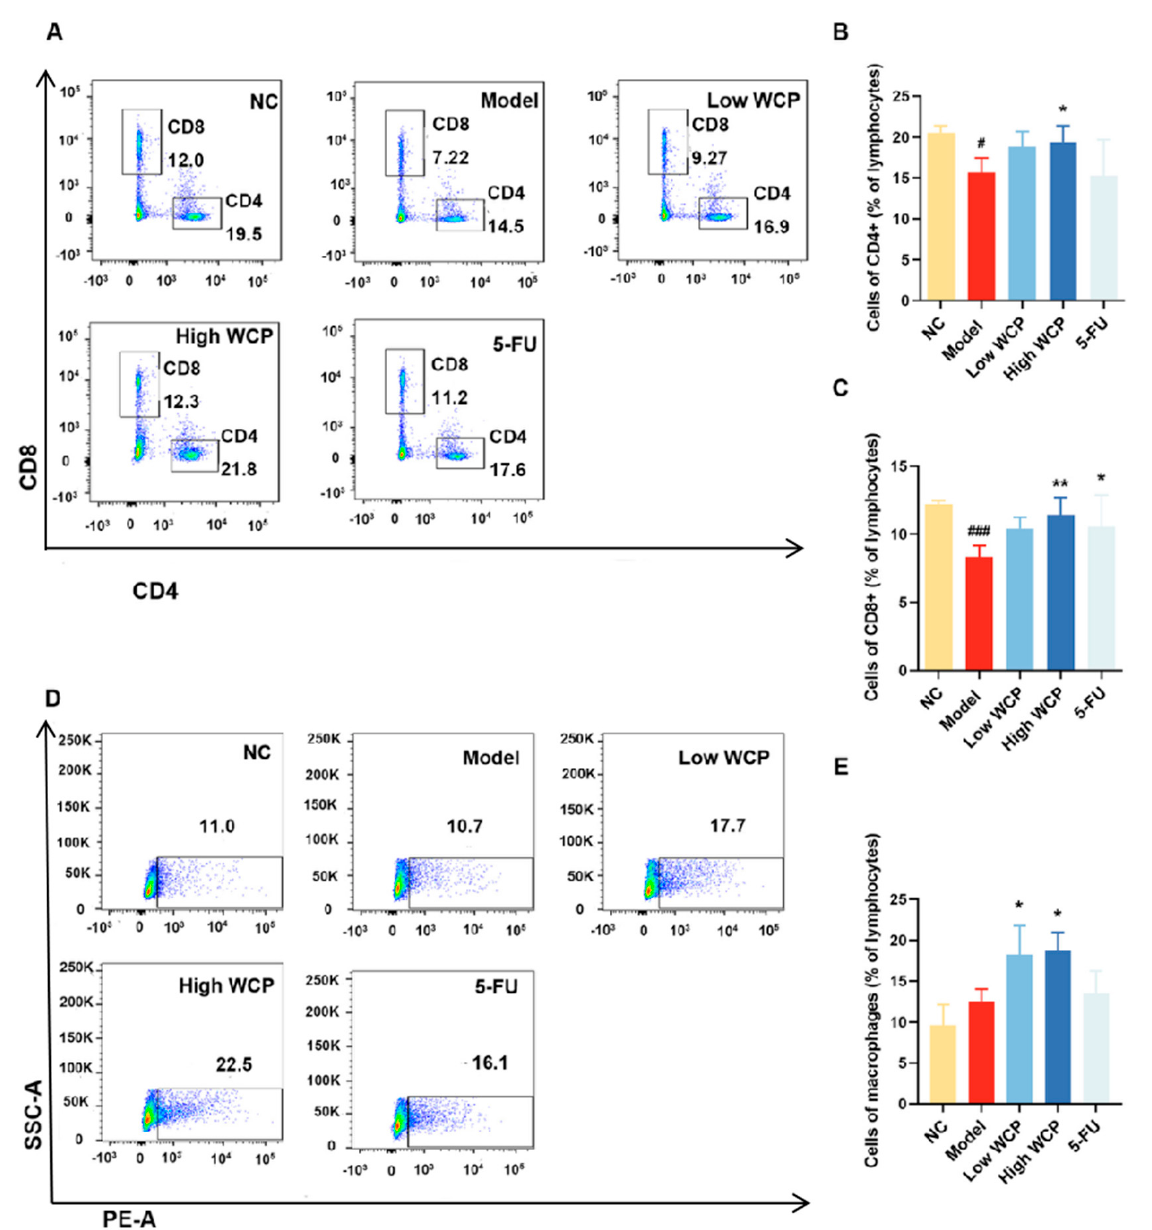
Figure 5. WCP changed the proportions of T lymphocytes and macrophages. ( A – C ) FITC/PE staining and flow cytometry analysis showed the proportions of CD4 + /CD8 + in the spleen of H22 tumor- bearing mice. ( D , E ) PE staining and flow cytometry analysis showed the proportions of macrophages in the spleen of H22 tumor-bearing mice. # p < 0.05, ### p < 0.001 compared to NC group; * p < 0.05, ** p < 0.01 compared to model